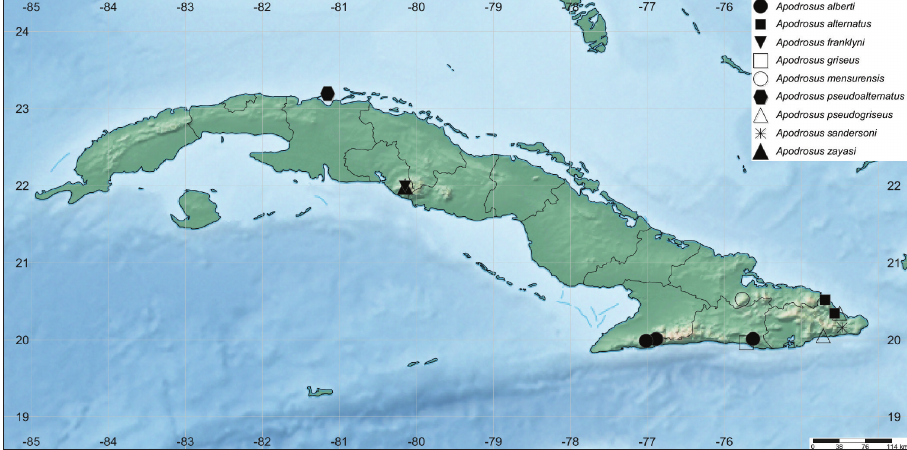
Figure 27. Distribution map of Cuban species of Apodrosus , made using